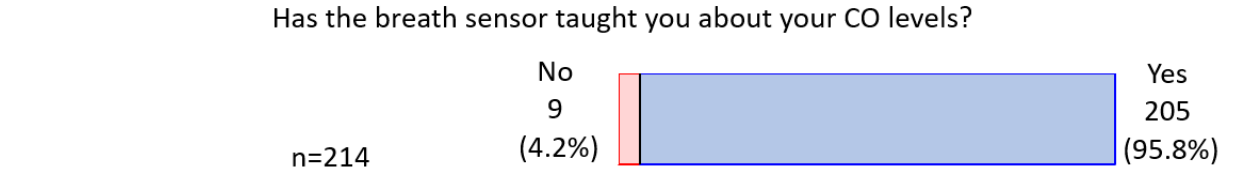
At 4 weeks, on a scale of 1-10, the mean score for how well participants understood their CO levels and trends as they relate to their smoking behavior was 8.0 (SD 2.1; Figure 13).